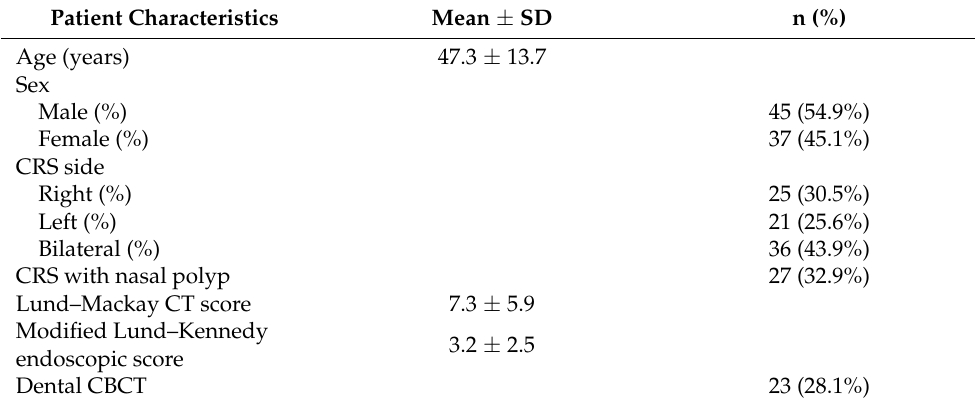
Table 1. Baseline characteristics of these 82 CRS patients.